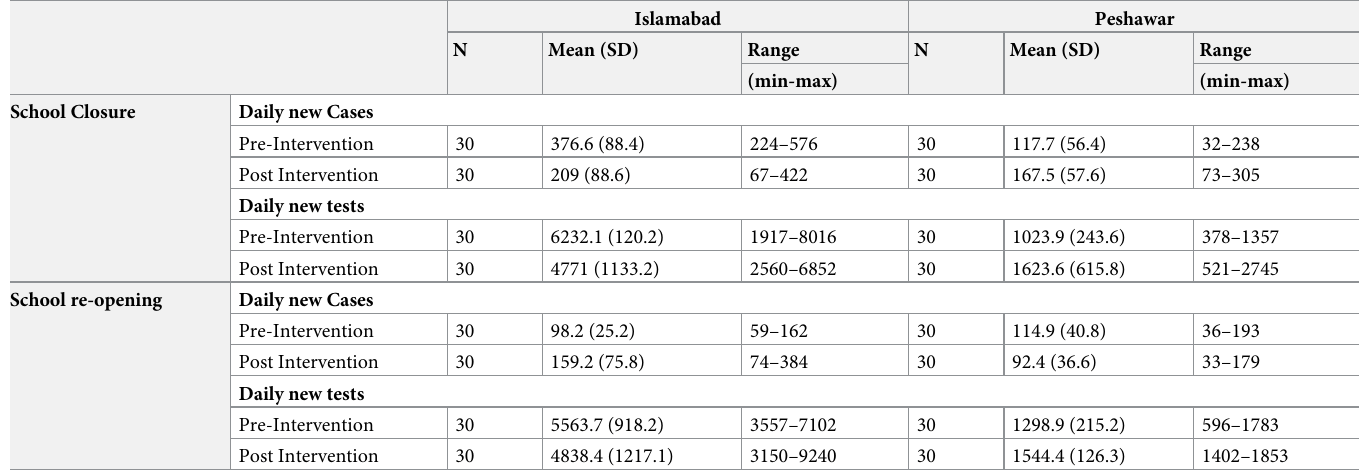
Table 1. Descriptive statistics pre-and post–policy implementation across Intervention and control